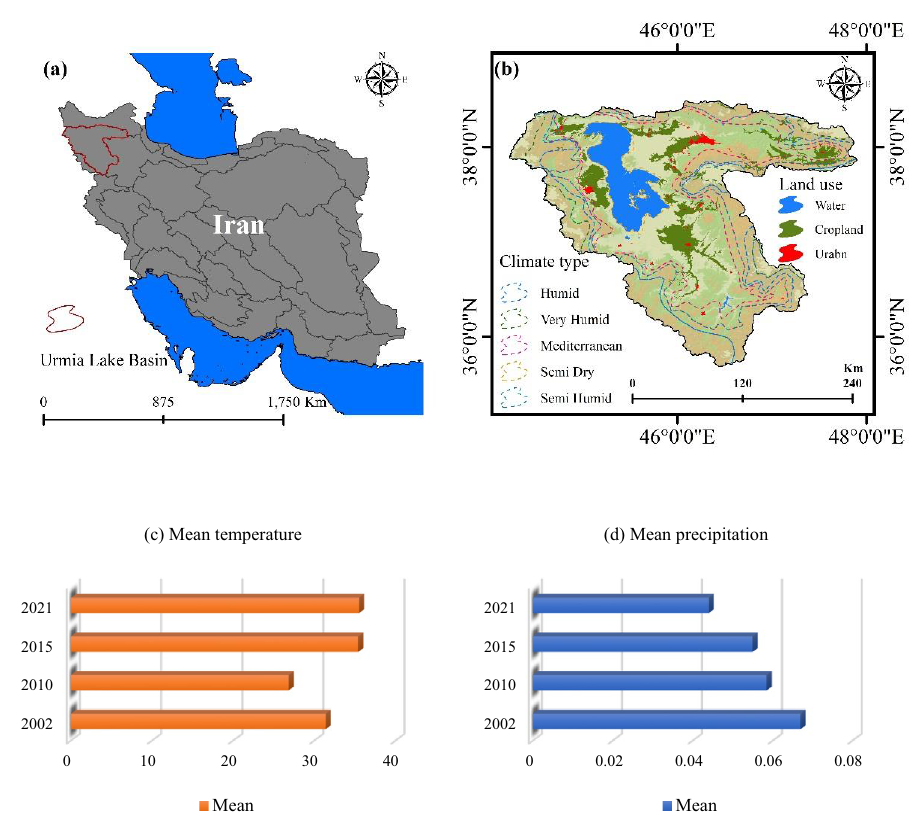
Figure 4. Location of the LUB, ( a ) in the north-western part of Iran. ( b ) Climate types and LULC of the LUB, generated in the ArcGIS 10.6 software (www. esri. com). ( c , d ) Are the mean temperature (°C) and precipitation (mm) of the study area from 2002 to 2021, respectively, generated in Microsoft Excel 2022 software (www. micro soft.